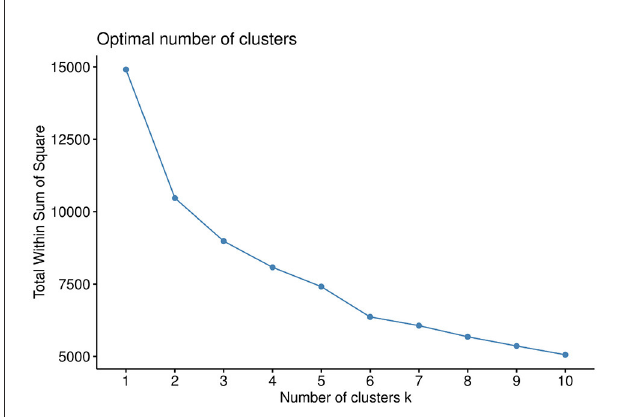
FIGURE1 Elbow value figure of optimal number of